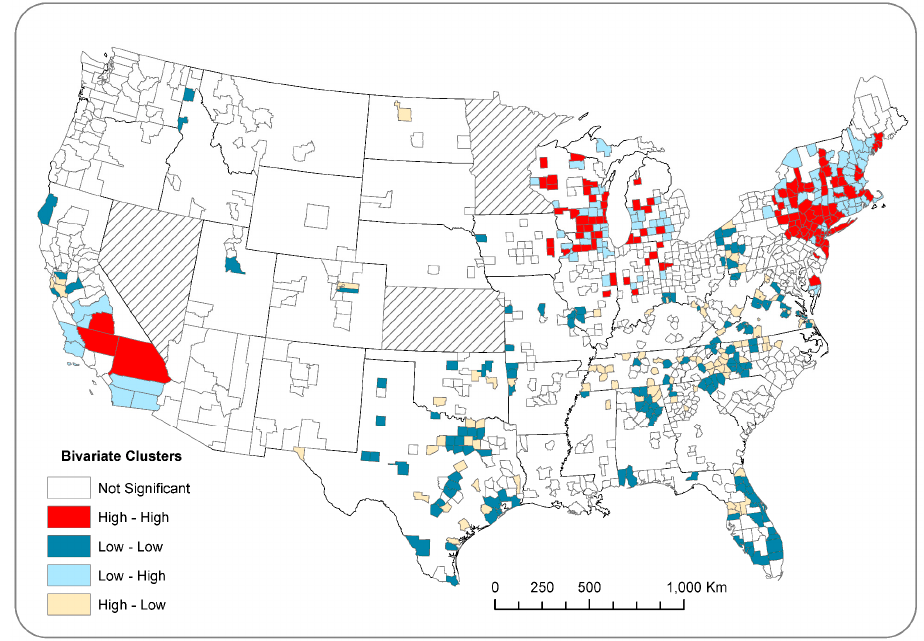
Figure 5. Bivariate LISA map showing clusters of counties with similar ovarian cancer rates and counts of paper mills (i.e., High–High or Low–Low on map).